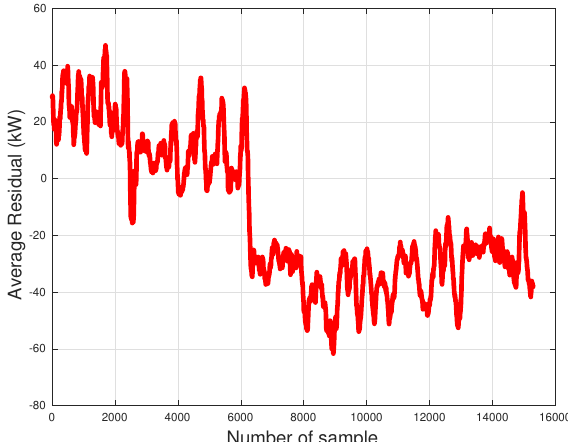
Figure 19. Residual between measurements and model estimates for T01 in WF2 for the year 2016 in Region 2, after being averaged for every 200